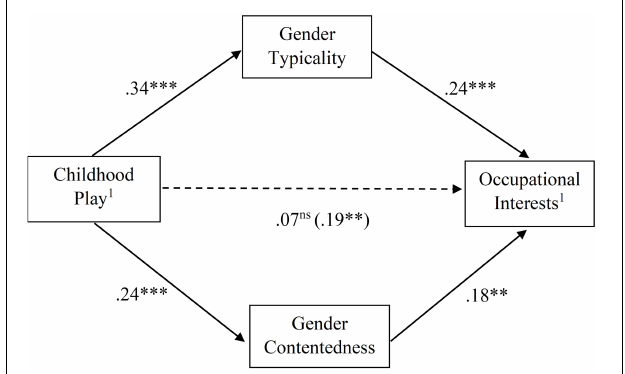
FIGURE 1 | Final multiple mediator model in men. 1 Higher scores on these measures indicate higher male-typical/lower female-typical traits. Standardised coefficients are reported. For the path from gender-related childhood play to gender-related occupational interests, the coefficient within the brackets indicates the total effect (without considering the mediators) and the coefficient outside the brackets indicates the direct effect (after taking into account the mediators). In this model, the relation between childhood play and occupational interests became non-significant after the mediators were introduced, indicating full mediation. ∗ p < 0.05, ∗∗ p < 0.01, ∗∗∗ p <